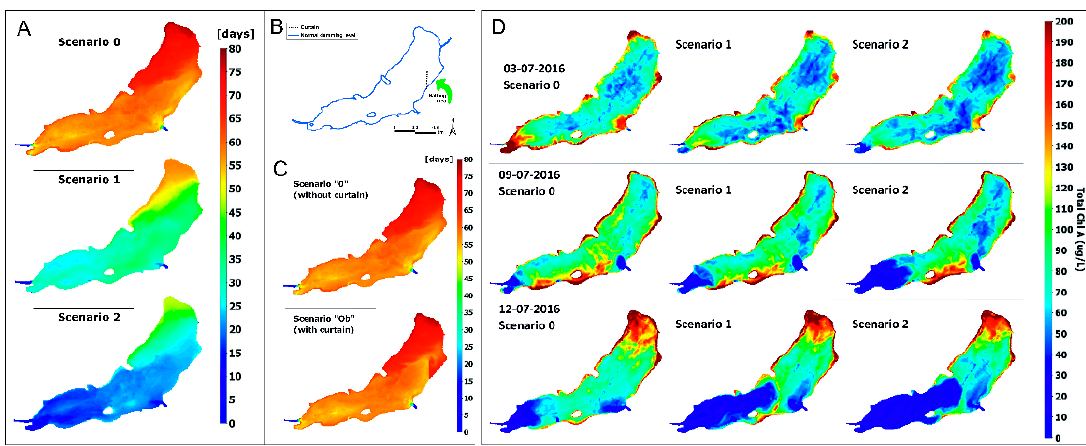
Figure 9. Impact of the catchment area restoration on the water retention time in the Paprocany reservoir ( A ); impact of the curtain on the water retention time ( B ); curtain (barrier) protecting the bathing area from inflow of polluted waters ( C ); chlorophyll concentration change in July according to scenarios 0, 1, and 2 ( D ).